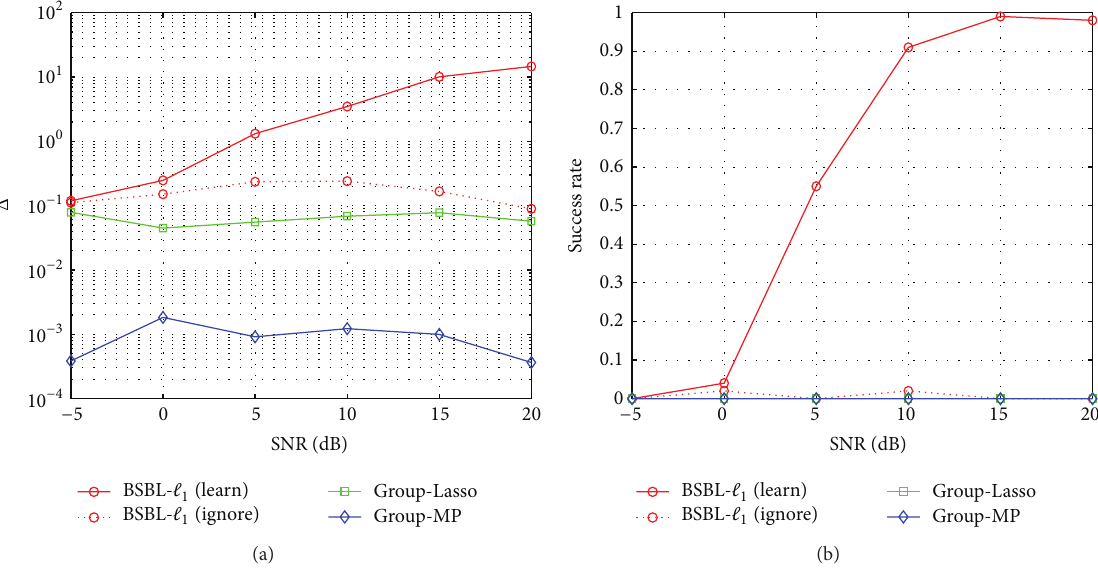
Figure 6: Comparison of metrics versus SNR in dense targets case. Grid distance is 10m. (a) Δ; (b) success